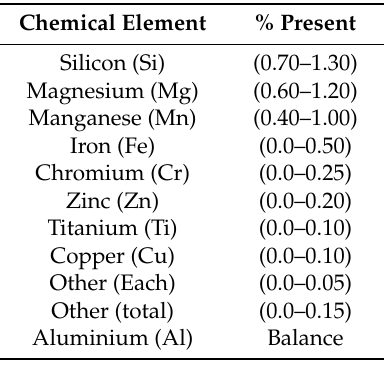
Table 1. Element composition of the A6082 Al alloy (wt %) [20].